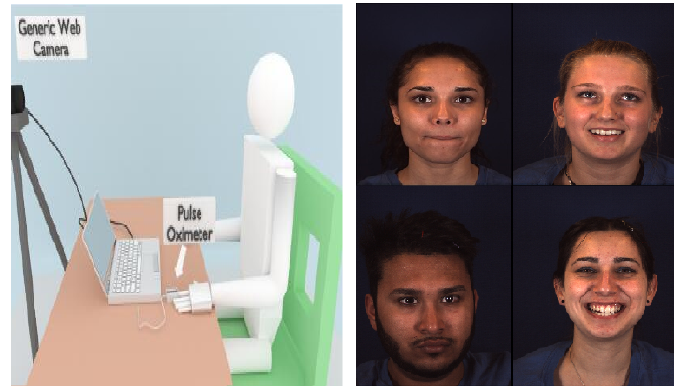
Figure 2. Experimental set up and some sample images from the MMSE database.